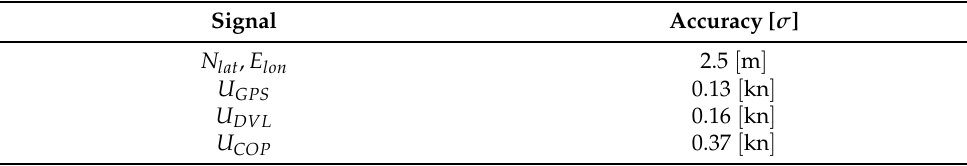
Table 1. Estimated accuracy (1 σ ) of motion and weather signals, according to manufacturers or weather providers’ documentation